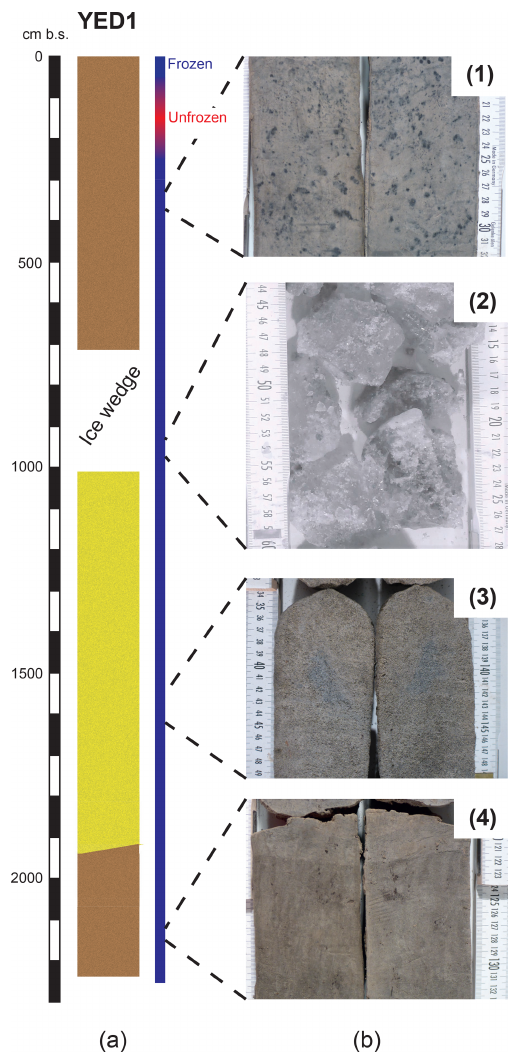
Figure 3. (a) Overview of the Yedoma core. The depth is given in centimeters below the surface (cmb.s.); the state after core re- trieval is given using colors (blue – frozen; red – unfrozen); the location of the ice wedge is labeled; brown illustrates silty sedi- ments and yellow represents sandy sediments. (b) Detailed pictures of the YED1 core: (1) 332–317cmb.s. – picture of unit Y1 showing black organic-rich inclusions within the gray silty matrix; (2) 960– 944cmb.s. – picture of the wedge ice in Y2; (3) 1549–1532cmb.s. – picture of Y3 showing a coarse sandy material with no visible cryostructures or organic material; (4) 2133–2117cmb.s. – picture of Y4 showing a gray silty matrix with some dark organic